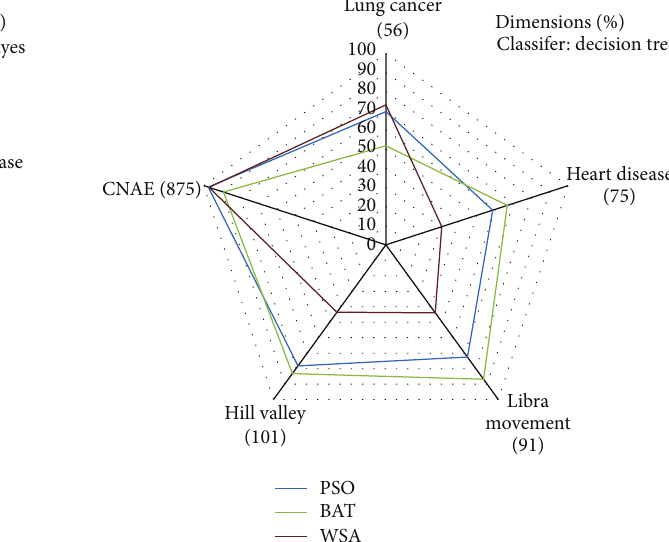
Figure 9: Results in consumption time for Na¨ıve Bayes shown visually in radar chart.